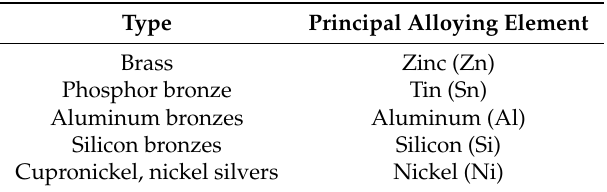
Table 1. Types of copper